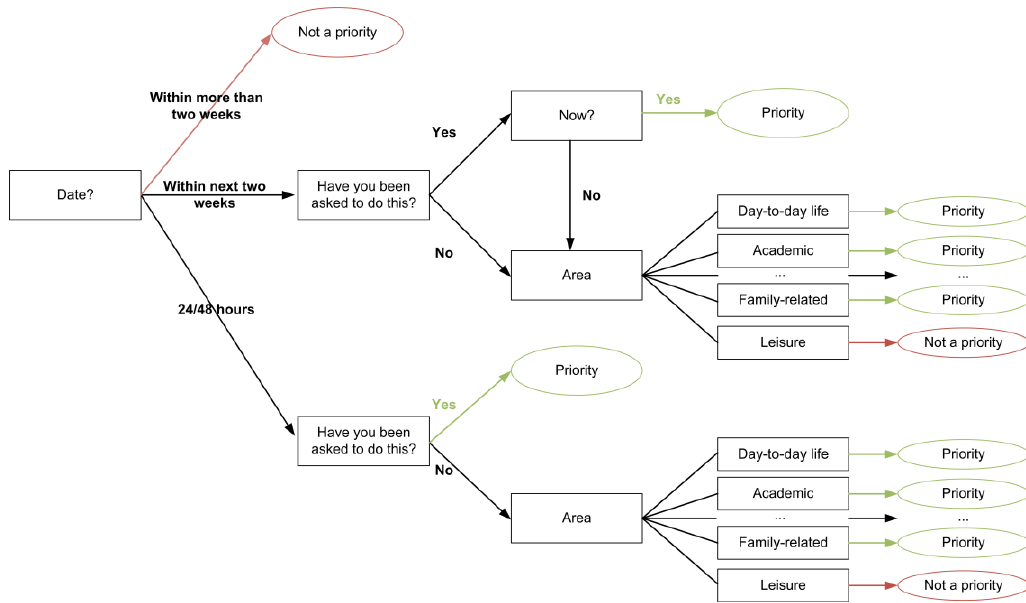
Figure 3. Implemented Decision